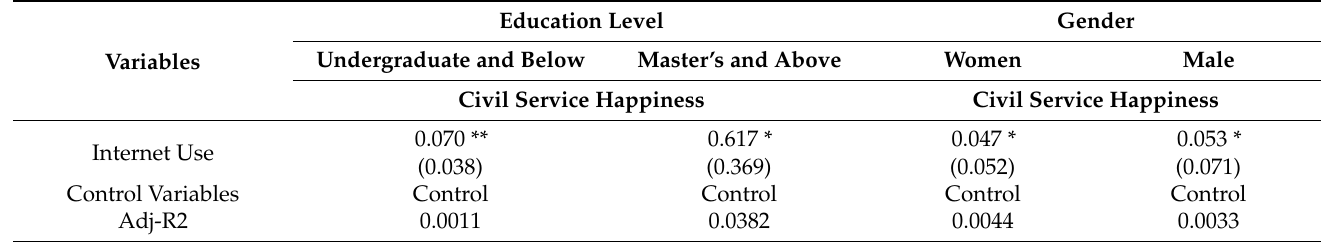
Table 5. Heterogeneity test for different literacy levels and different gender status.